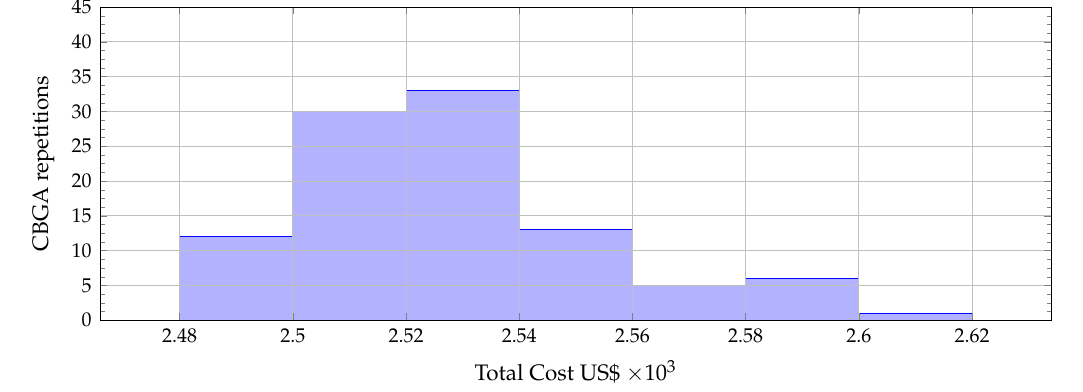
Figure 14. Behavior of the solutions in the 69-node test system after 100 repetitions.